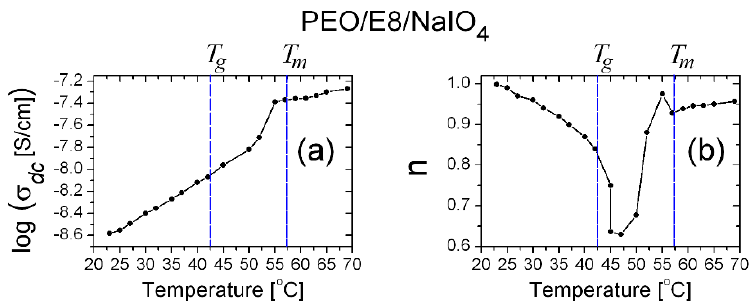
Figure 17. Temperature dependencies of the parameters σ dc ( a ) and n ( b ) obtained by fits using Equation (2) (KWW + HN model). The fits were performed on ε ″ ( f ) spectra of the PEO/E8/NaIO 4 composite film that corresponded to temperature in the range of 23–68 °C.